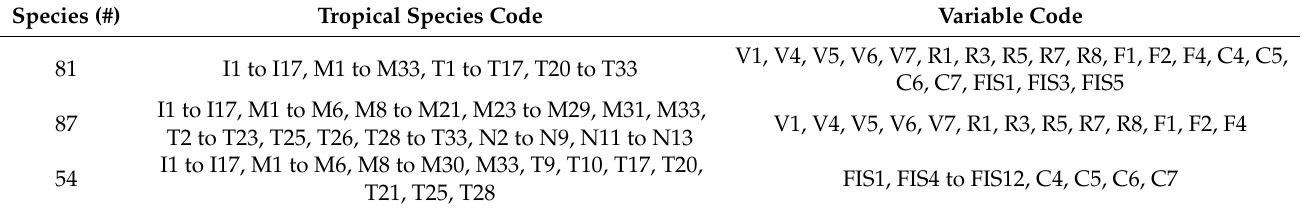
Table 3. Number and list of the tropical wood species (codes as in Table 1) and variables (codes as in Table 2) included in each analysis.